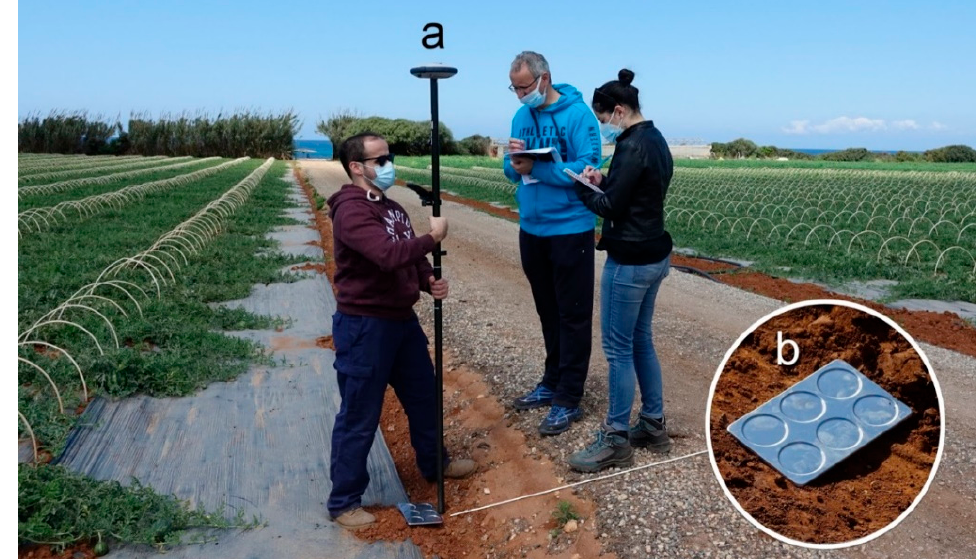
Figure 11. ( a ) The RTK GNSS that was used for the collection of the GCPs; ( b ) the rectangular